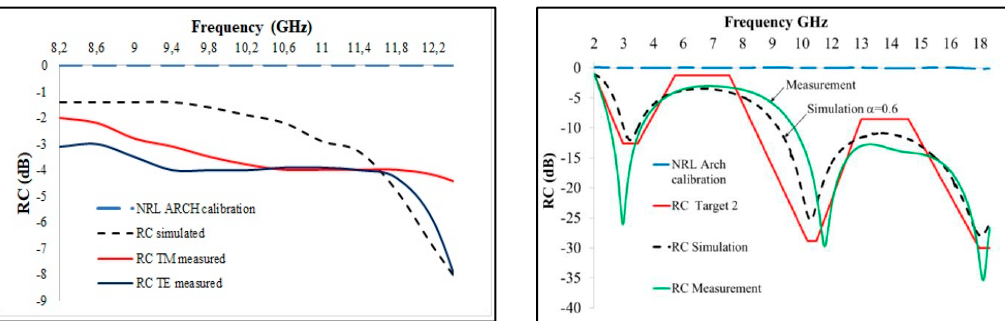
Figure 3. Specimens under investigation: Panel 1 (left) and Panel 2 (right) surface size is 200 mm × 200 mm.